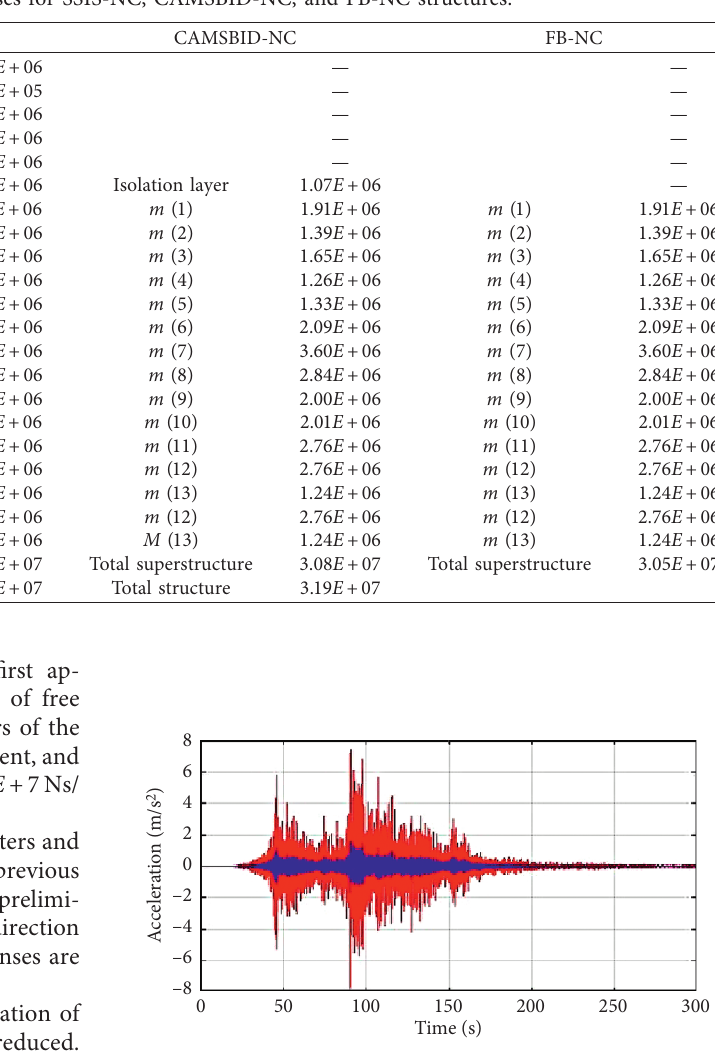
Figure 4: Base acceleration responses of SSIS-NC structure (blue) in X -direction under the effect of the Tohoku earthquake